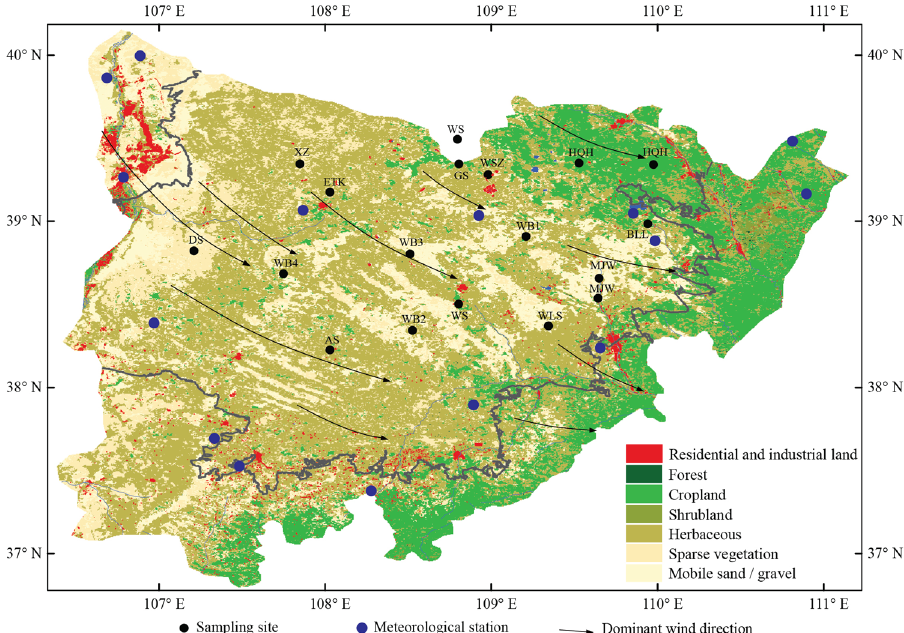
Figure 1. Locations of the Mu Us Desert, sample sites and land uses. The areas outlined in grey indicate areas affected by desertification from the mid-1970s to 2010. The black and blue dots indicate the locations of the sampling sites and meteorological stations, respectively, used in this study (The figure was finished using Arcgis software (version 10.1, ESRI Inc., Redlands, California, USA), which can be downloaded from the internal network of Institute of Geographic Sciences and Natural Resources Research, Chinese Academy of Sciences.).